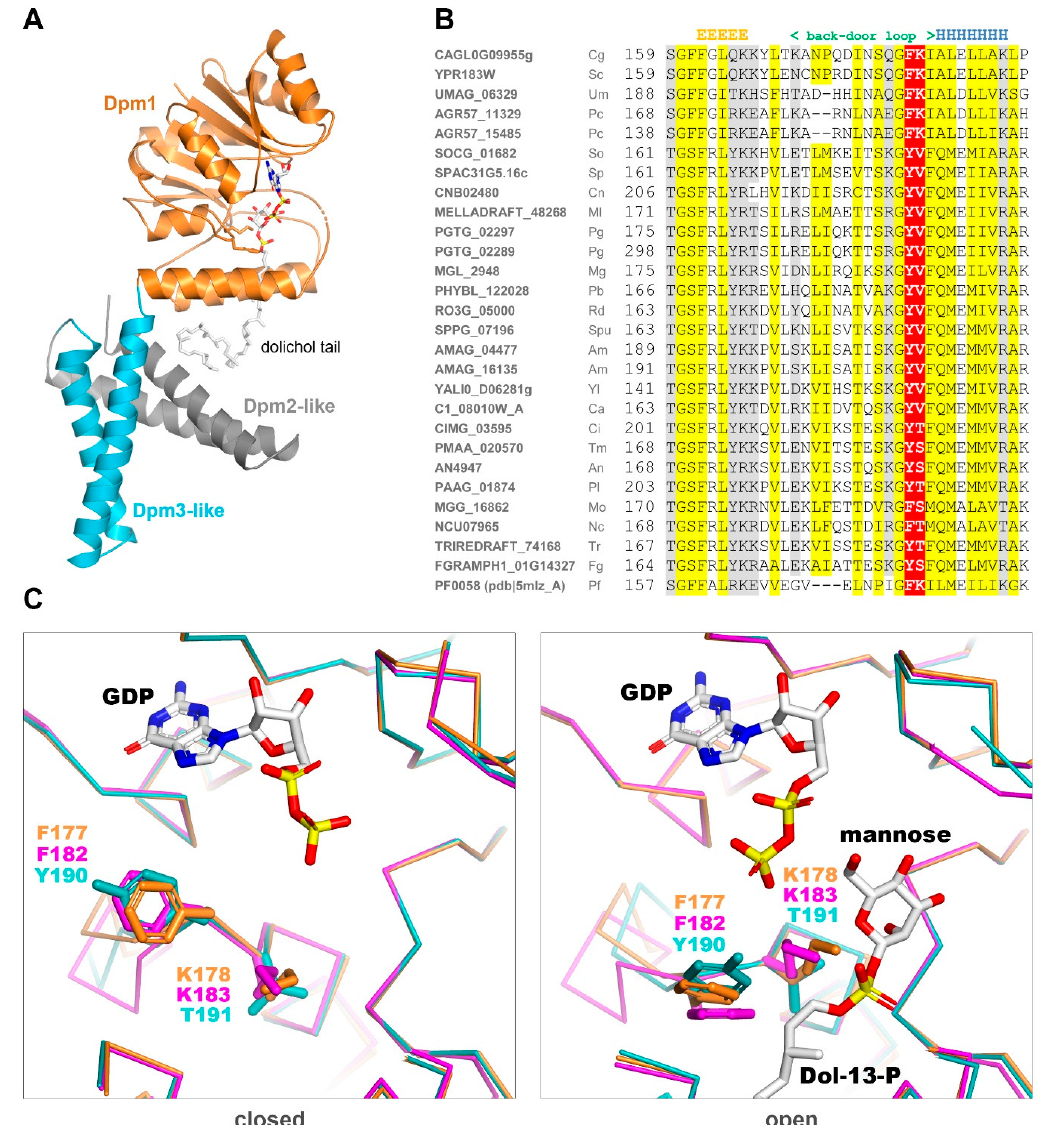
Figure 4. 3D model of DPMS. ( A ) Overall structure of P. furiosus DPMS in complex with guanosine diphosphate (GDP) and dolichyl phosphate mannose (dHPren-11-P) (pdb | 5mm1) ( B ) Multiple sequence alignment of the “back door” loop region of Dpm1. Residue conservation is denoted with the following scheme: hydrophobic positions—highlighted in yellow, polar amino acids—highlighted in grey. The FK motif or its equivalent is highlighted in red. Species names are abbreviated as follows: Cg, Candida glabrata CBS 138; Sc, Saccharomyces cerevisiae S288c; Um, Ustilago maydis 521; Pc, Phanerochaete chrysosporium RP-78; So, Schizosaccharomyces octosporus yFS286; Sp, Schizosaccharomyces pombe 972h-; Cn, Cryptococcus neoformans var. neoformans JEC21; Ml, Melampsora larici-populina 98AG31; Pg, Puccinia graminis f. sp. tritici CRL 75-36-700-3; Mg, Malassezia globosa CBS 7966; Pb, Phycomyces blakesleeanus NRRL 1555; Rd, Rhizopus delemar RA 99-880; Spu, Spizellomyces punctatus DAOM BR117; Am, Allomyces macrogynus ATCC 38327; Yl, Yarrowia lipolytica CLIB122; Ca, Candida albicans SC5314; Ci, Coccidioides immitis RS; Tm, Talaromyces marneffei ATCC 18224; An, Aspergillus nidulans FGSC A4; Pl, Paracoccidioides lutzii Pb01; Mo, Magnaporthe oryzae 70-15; Nc, Neurospora crassa OR74A; Tr, Trichoderma reesei QM6a; Fg, Fusarium graminearum PH-1; Pf, Pyrococcus furiosus . ( C ) 3D models of active centre region of Dpm1 in closed and open form from S. cerevisiae and T. reesei superimposed onto PfDPMS structure in “back door” closed (pdb | 5mlz) and open (pdb | 5mm1) states. P. furiosus structure is shown in orange while Trichoderma and yeast models in teal and magenta,